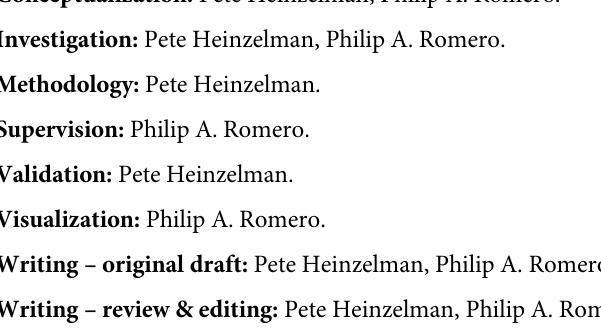
populations of yeast carrying identical display plasmids, i.e., wild-type ACE2, feature 25% or greater cells (leftmost yeast in ACE2 histograms) that do not display any protein. S6 Fig. Flow cytometry dot plots for wild type and selected SNV ACE2s. The X-axes denote Alexa488 fluorescence (ACE2 display) and Y-axes denote Alexa647 fluorescence (ACE2 bind- ing to spike protein). The plots depict dots for approximately 3 � 10 4 yeast cells. The dark blue line denotes upper limit of Alexa488 signal (ACE2 display) for wild-type ACE2. The yeast were incubated with 5 nM spike RBD prior to flow cytometric analysis. For biological reasons that are poorly understood, even homogeneous populations of yeast carrying identical display plas- mids, i.e., wild-type ACE2, feature 25% or greater cells (lower left region of plots) that do not display any protein. S1 Table. Mutation effect values and human allele frequencies for all 3,571 ACE2 amino acid substitutions observed by Illumina sequencing analysis of the yeast surface-displayed ACE2 random mutant library. S2 Table. Mutation effect values and human allele frequencies for ACE2 SNVs chosen for further characterization in spike binding flow cytometry